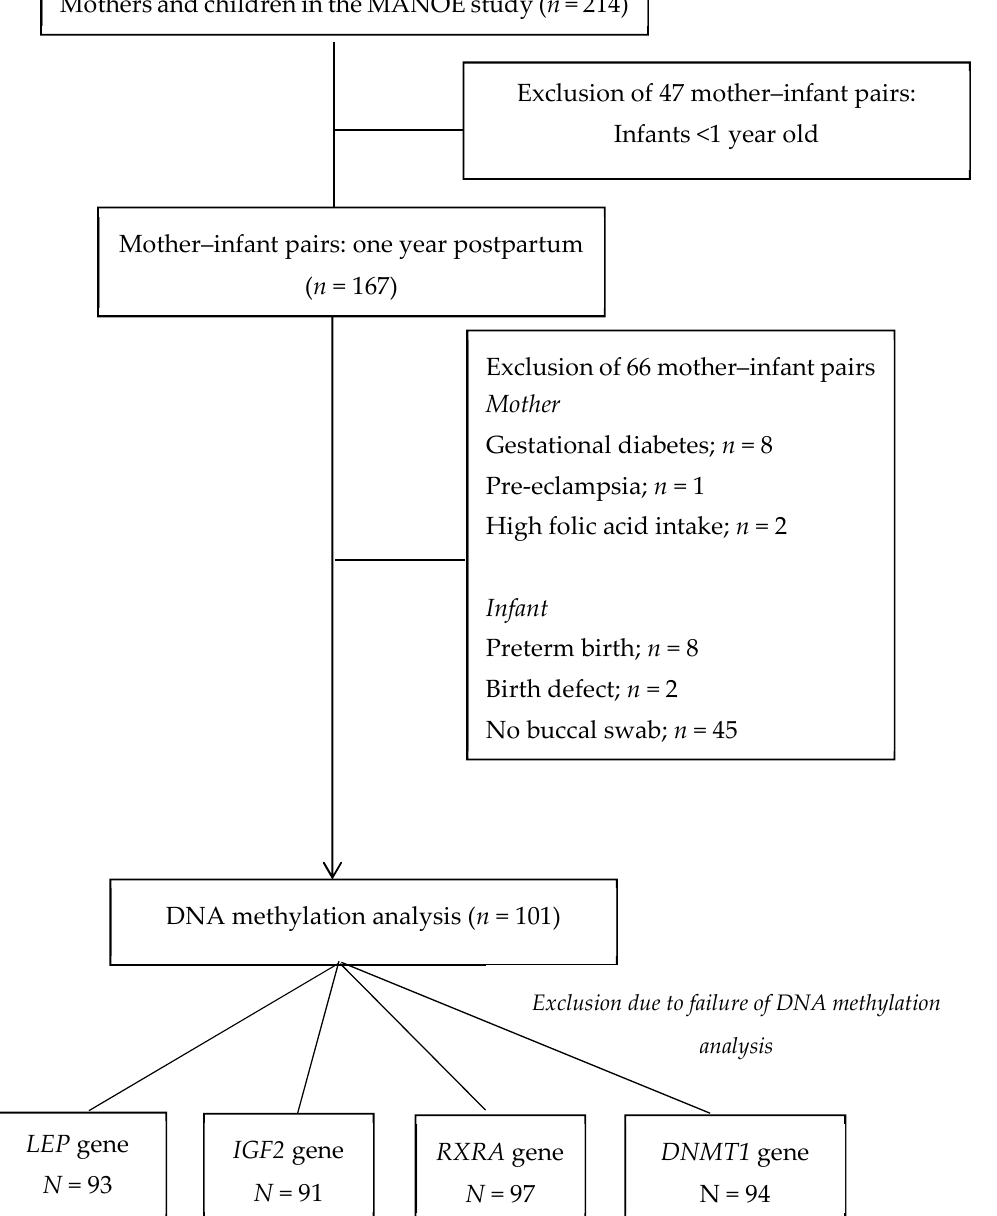
Figure 1. Flowchart of mothers and children recruited in the Maternal Nutrition and Offspring’s Epigenome (MANOE) study.